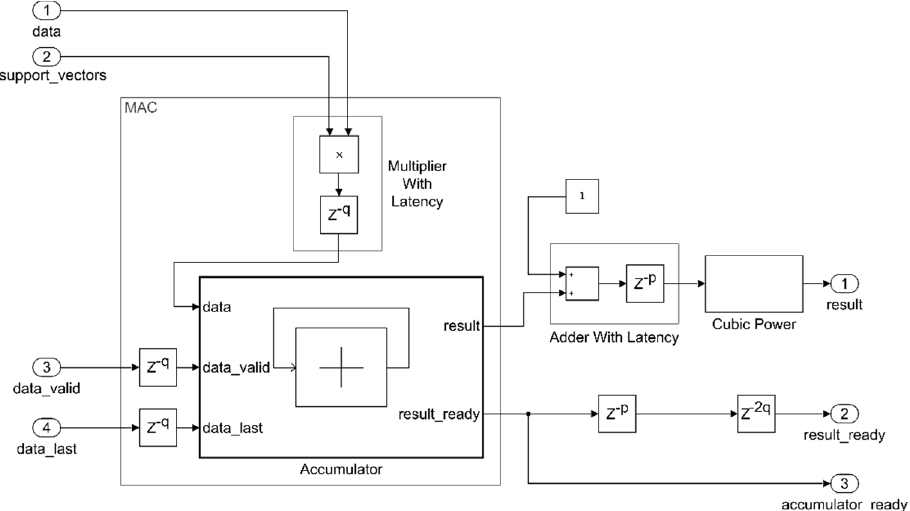
Figure 3. Simulink cubic kernel implementation.